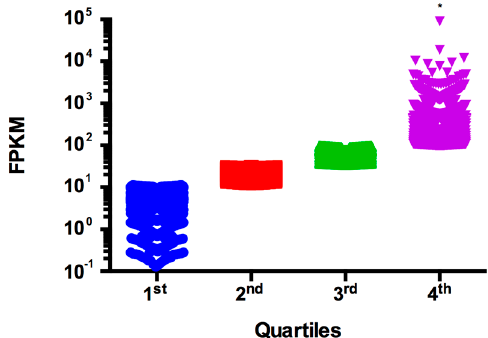
Figure 3. Transcriptional landscape of C. gattii R265 genes during pulmonary infection. FPKM values were determined from reads aligned to the C. gattii R265 genome using Cufflinks. FPKM values were distributed into quartiles and statistically analyzed using ANOVA followed by Tukey’s multiple comparisons test. The quartiles 1 (blue), 2 (red) and 3 (green) do not present statistical difference. The fourth quartile (purple) concentrates the abundant transcripts and has significant statistical difference (*) compared with others.